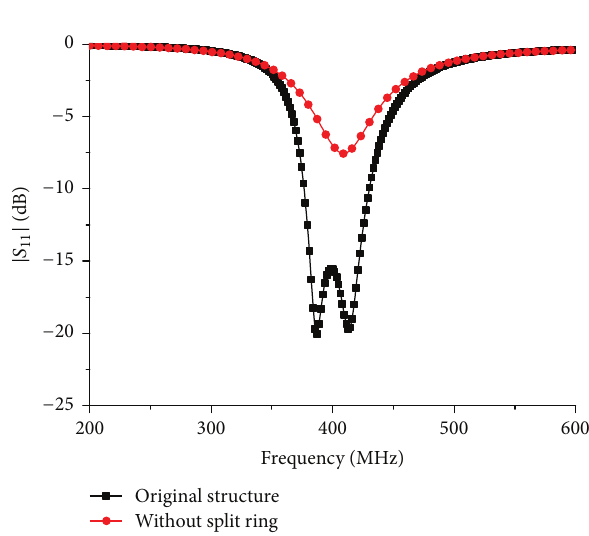
Figure 5: Simulated |𝑆 11 | of the case without split ring compared to the original antenna.